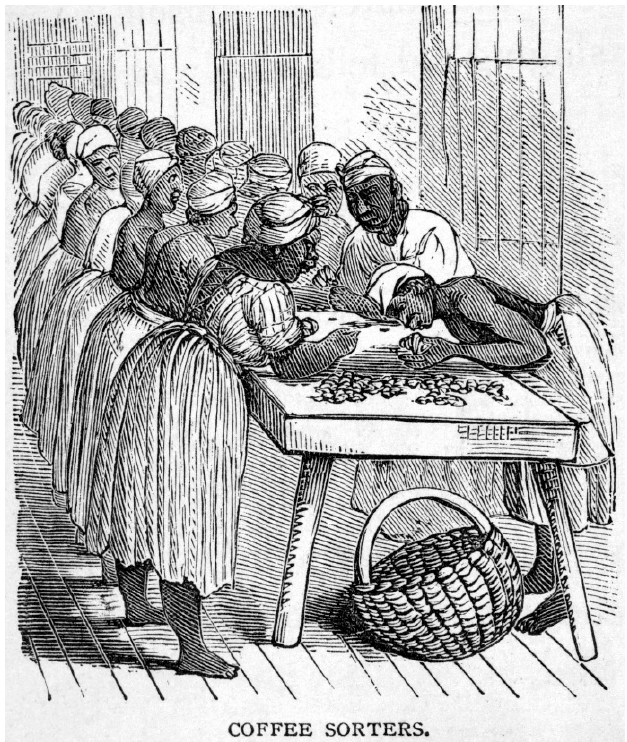
Figure 6. From Hazard’s Cuba With Pen and Pencil . While the woman closest to the frame of the image on the left wears a full dress, several women work wearing only a skirt. “Coffee Sorters, Cuba, ca. 1866”, Slavery Images: A Visual Record of the African Slave Trade and Slave Life in the Early African Diaspora , accessed 31 July 2020, http://slaveryimages.org/s/slaveryimages/item/872.